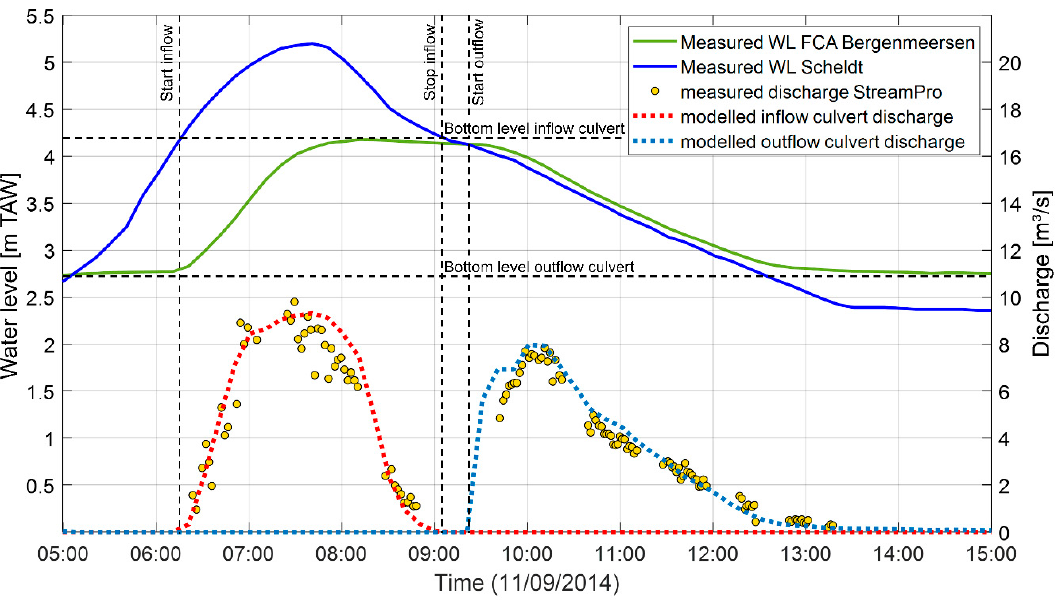
Figure 4. Calibrated modeled discharges compared to measured discharges through the in- and outflow culverts of FCA with CRT Bergenmeersen.